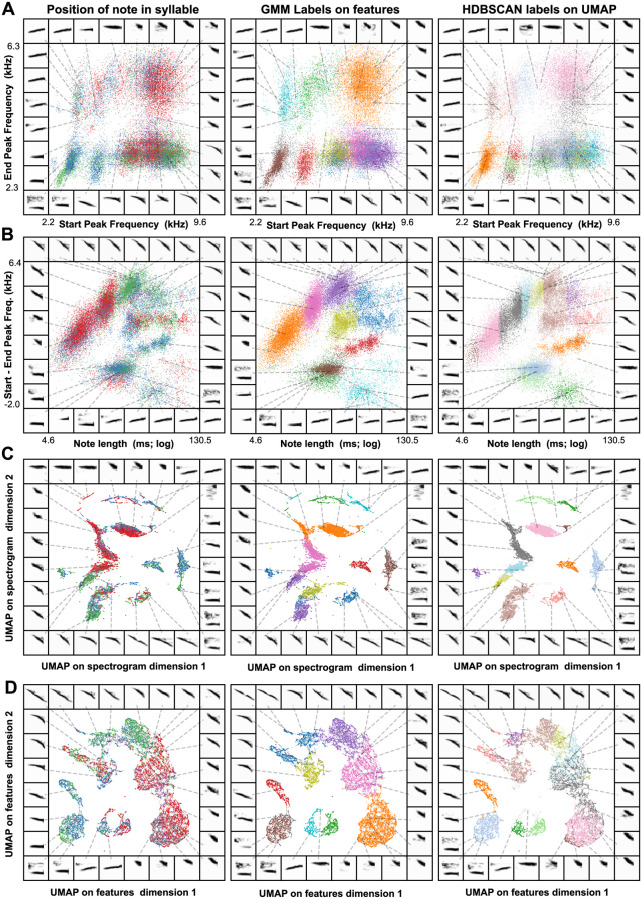
Comparing latent and known features in swamp sparrow song.(A) A scatterplot of the start and end peak frequencies of the notes produced by birds recorded in Conneaut Marsh, PA. The left panel shows notes colored by the position of each note in the syllable (red = first, blue = second, green = third). The center panel shows the sample scatterplot colored by a Gaussian Mixture Model labels (fit to the start and end peak frequencies and the note duration). The right panel shows the scatterplot colored by HDBSCAN labels over a UMAP projection of the spectrograms of notes. (B) The same notes, plotting the change in peak frequency over the note against the note’s duration. (C) The same notes plotted as a UMAP projection over note-spectrograms. (D) The features from (A) and (B) projected together into a 2D UMAP space.